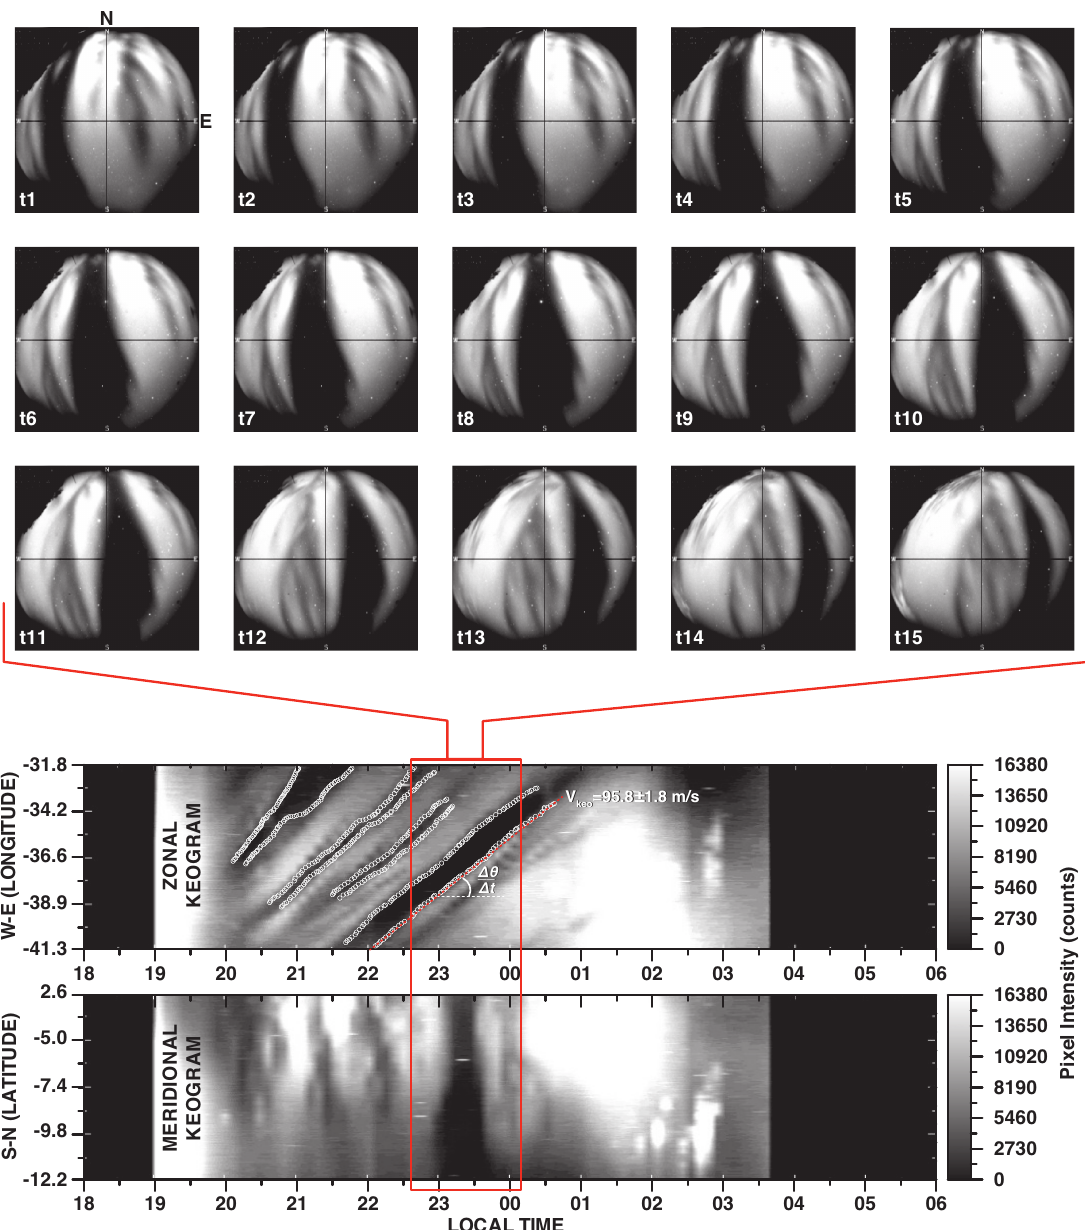
Figure 1. Illustration of how to build and derive the zonal drift velocity of an equatorial plasma bubble (EPB) from keogram